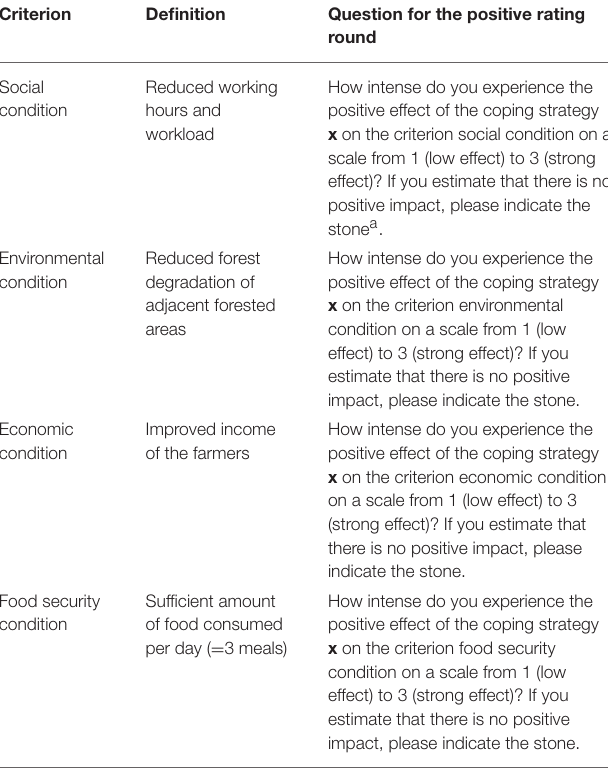
TABLE 3 | The four sustainability criteria, their definitions, and the respective questions of the positive rating